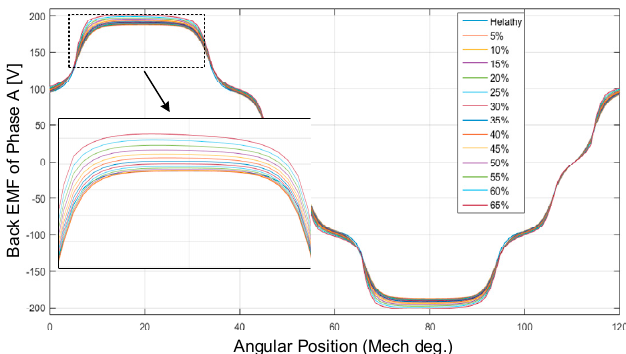
Figure 17. Back EMF under SE condition varies from 0% to 65%.